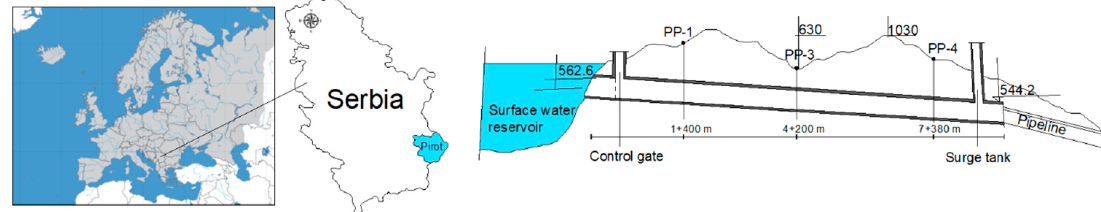
Figure 1. Geographic position of the study area and schematic representation of the longitudinal section of the tunnel, including elevations.